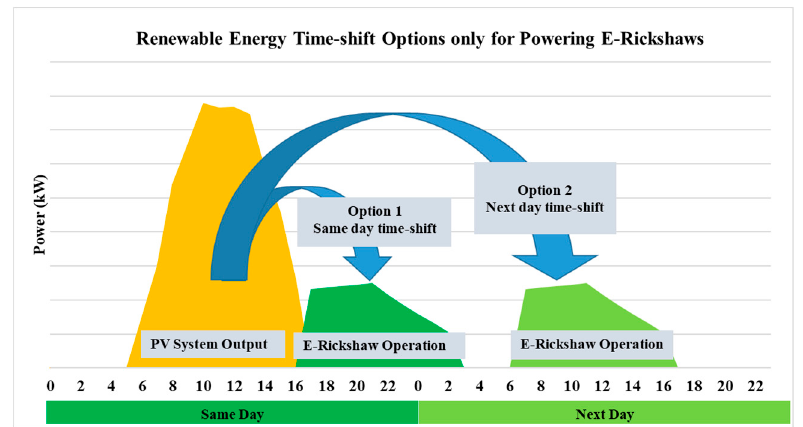
Figure 15. Renewable energy time-shift options for powering e-rickshaws. Option 1 offers same day time-shift and Option 2 offers next day time shift.